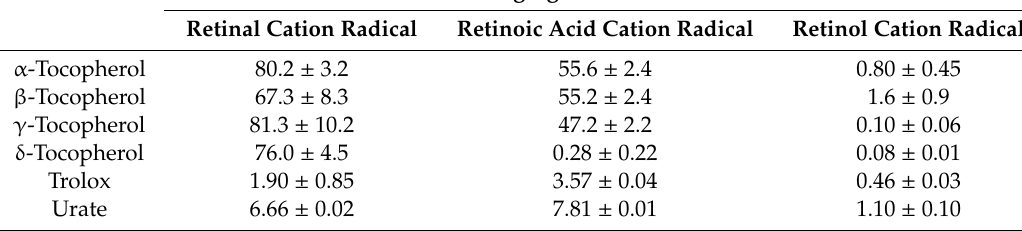
Table 1. Bimolecular rates of scavenging of retinoid cation radicals by tocopherols, trolox and urate. To determine the bimolecular rate constants of interactions between tocopherols and retinoid cation radicals, both reactants were solubilized in benzene. To determine the bimolecular rate constants of interactions between retinoid cation radicals and trolox or urate, the retinoids were incorporated into Triton X-100 micelles, whereas hydrophilic antioxidants were solubilized directly in 10 mM of phosphate bu ff er pH